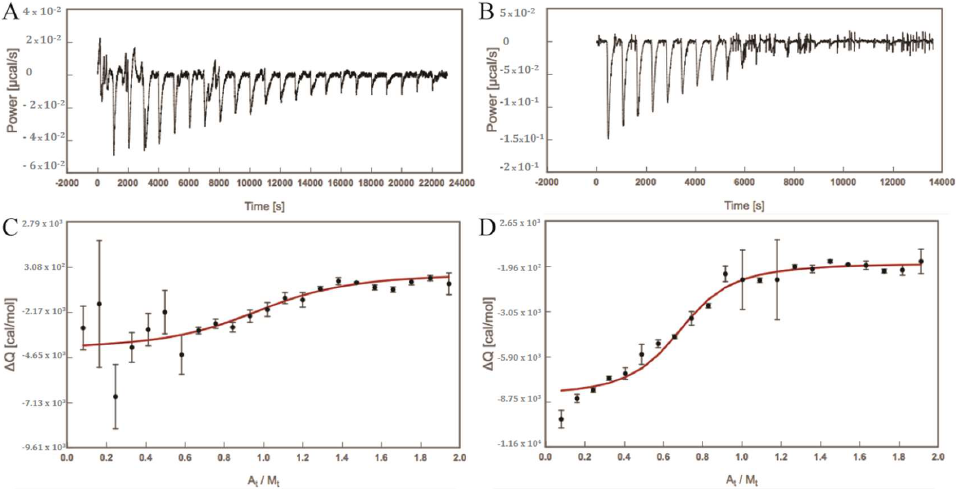
Figure 2. Enthalpogram of the dimannose ( A ) binding to FimH [M]. Processed data ( A , B ) and their integrated signal ( C , D ) for Man α 1,2Man ( A , C ) and Man α 1,3Man ( B , D ). ∆ Q = ∆ H at constant pressure, integrated signal ( C , D ) for Manα1,2Man ( A , C ) and Manα1,3Man ( B , D ). ΔQ = ΔH at constant pressure, A t /M t = ligand/protein molar ratio. For more detail, see Section A t /M t = ligand/protein molar ratio. For more detail, see Section 4.2.